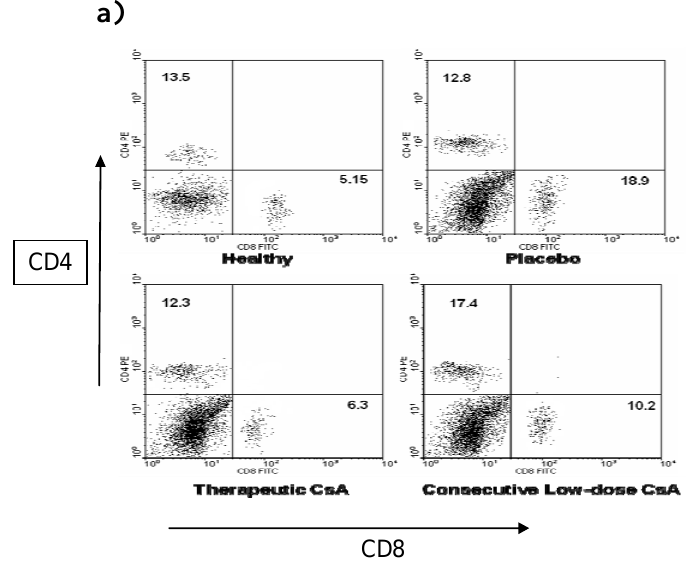
Figure 5. Flow cytometry analysis of spleen cells from mice grafted and differentially treated with CsA. Spleen cells were obtained after graft rejection or after finished the follow-up period of time. CD4 and CD8 positive cells were analyzed. a ) Representative dot plot of spleen cells from naïve mice, placebo-treated mice, therapeutic dose of CsA and consecutive low dose of CsA. Numbers indicate mean percentage of positive cells. b ) Average of percentage of CD4 + cells and c ) percentage of CD8 + cells. Bars show average ± SD, n = 4 mice per group; * P <